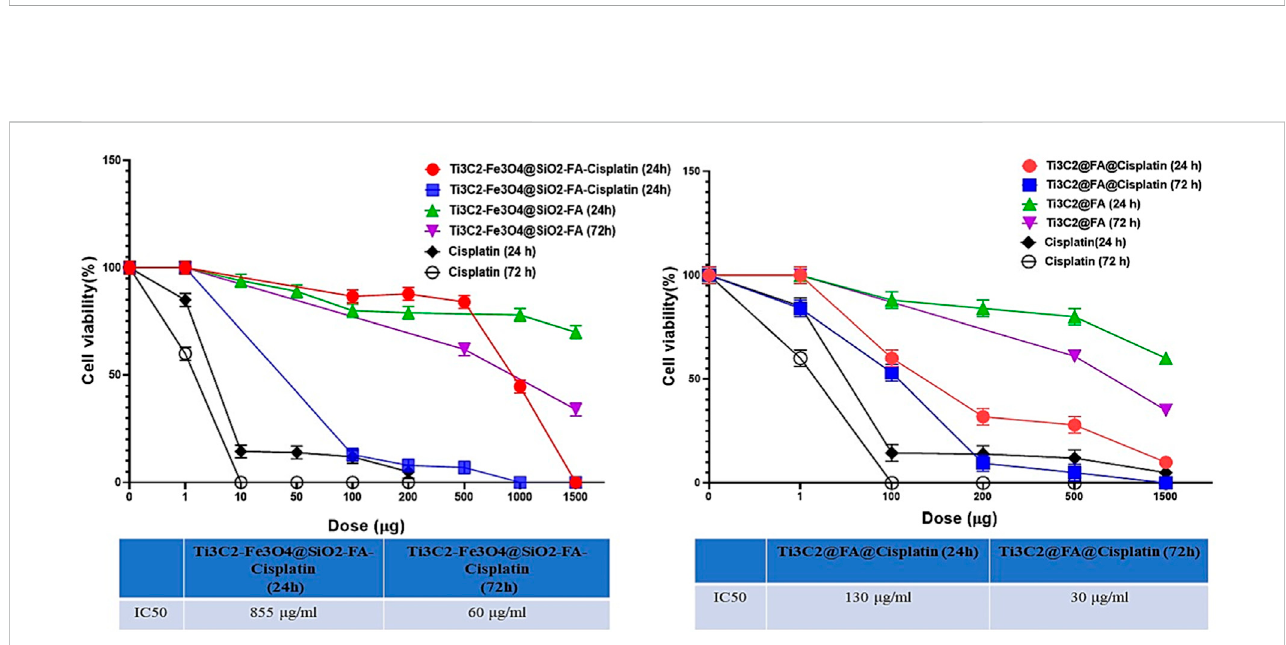
FIGURE 11 The MTT assay was used to assess cell viability after 24 h and 48 h incubation in TC1 cervix cancer cells to determine the ability of Ti 3 C 2 @FA@Cisplatin and